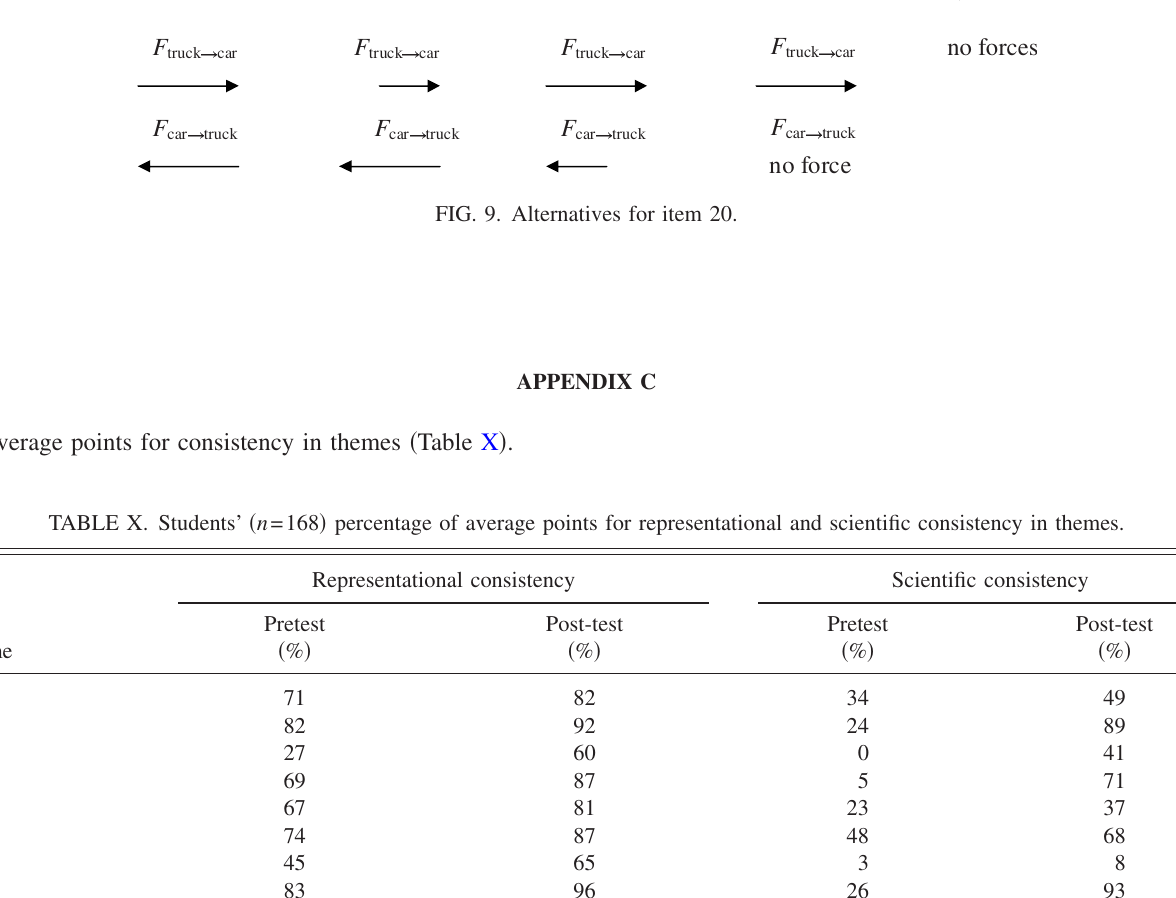
FIG. 9. Alternatives for item